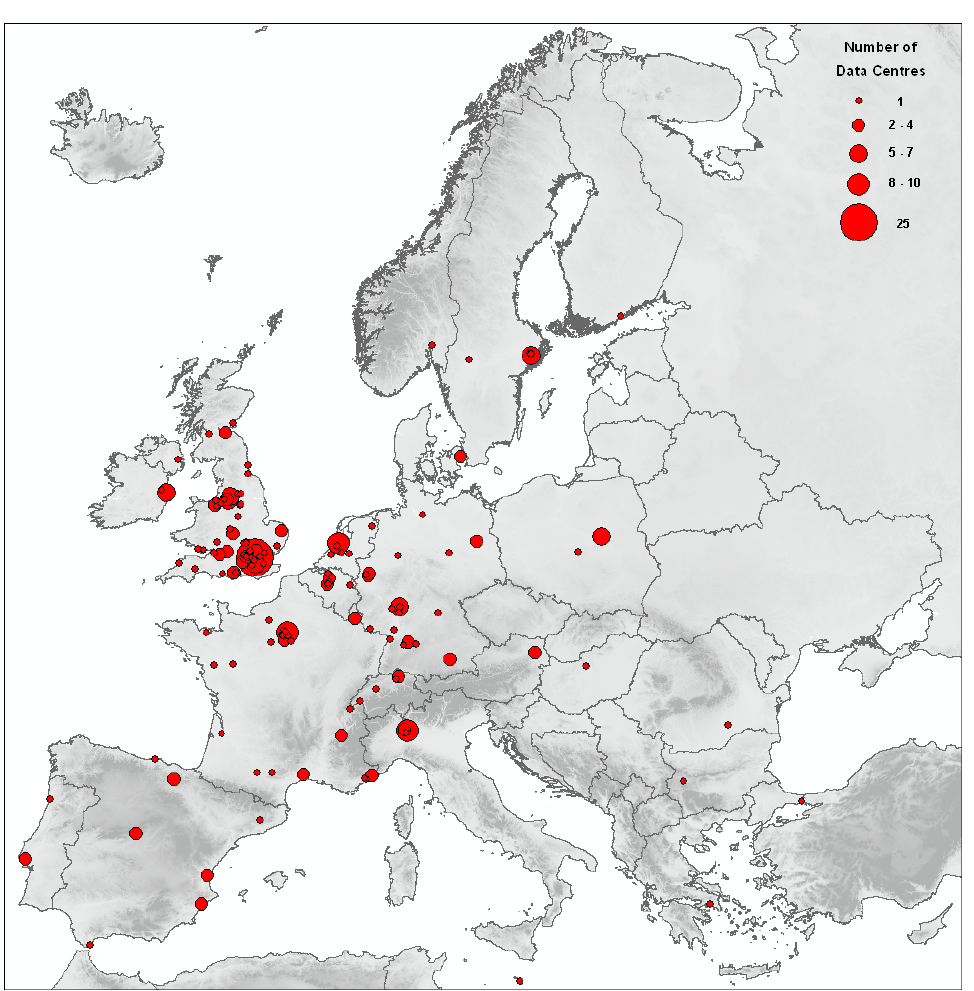
Figure 1. Geographical distribution of the data centres participating in the Code of Conduct (CoC).